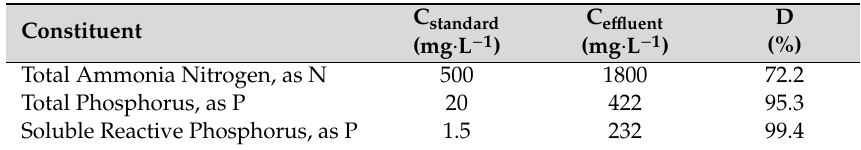
Table 3. Values of C e ffl uent , C standard and corresponding D (see Section 3.2.3 for details) for three POCs common to wastewater treatment facilities such as the Du ffi n Creek WWTP.